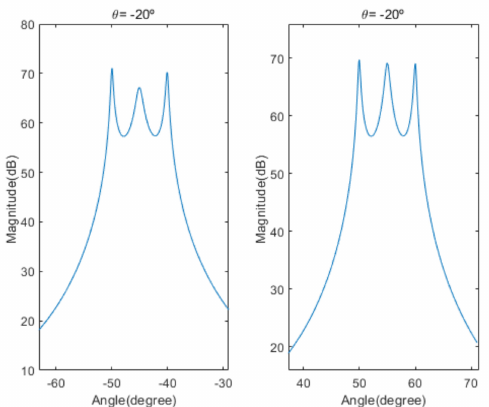
Figure 9. Spatial spectrum of Beamspace MUSIC in the proposed algorithm for the second scenario (elevation angle = − 20 ◦ ).